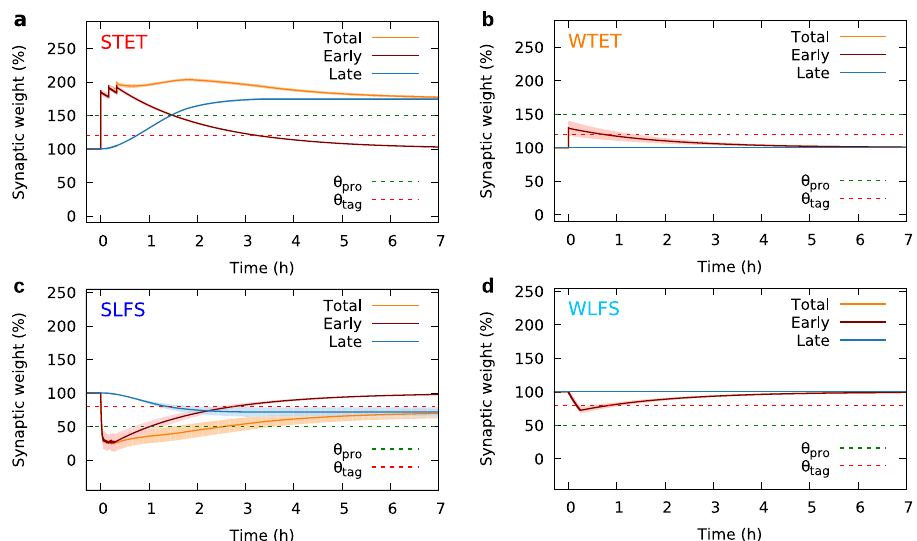
Fig. 2 Impact of strong and weak tetanic and low-frequency stimulation protocols at a single synapse. Each protocol (see Supplementary Fig. S1 for details) leads to the induction of a different type of synaptic plasticity: a late-phase potentiation, b early-phase potentiation, c late-phase depression, and d early-phase depression. The late-phase weight (blue line) is only changed by strong stimulation (STET, SLFS). The early-phase weight (red line) is affected by all protocols. Weak stimulation protocols (WTET, WLFS) suf fi ce to drive the early-phase weight across the threshold of tag formation ( θ tag , dashed red line), but not across the threshold of triggering protein synthesis ( θ pro , dashed green line). The total weight or synaptic ef fi cacy (orange) is the sum of early- and late-phase weight. Averaged over 100 trials; error bands show the standard deviation. The late-phase weight has been shifted for graphical reasons (cf. “ Methods ”